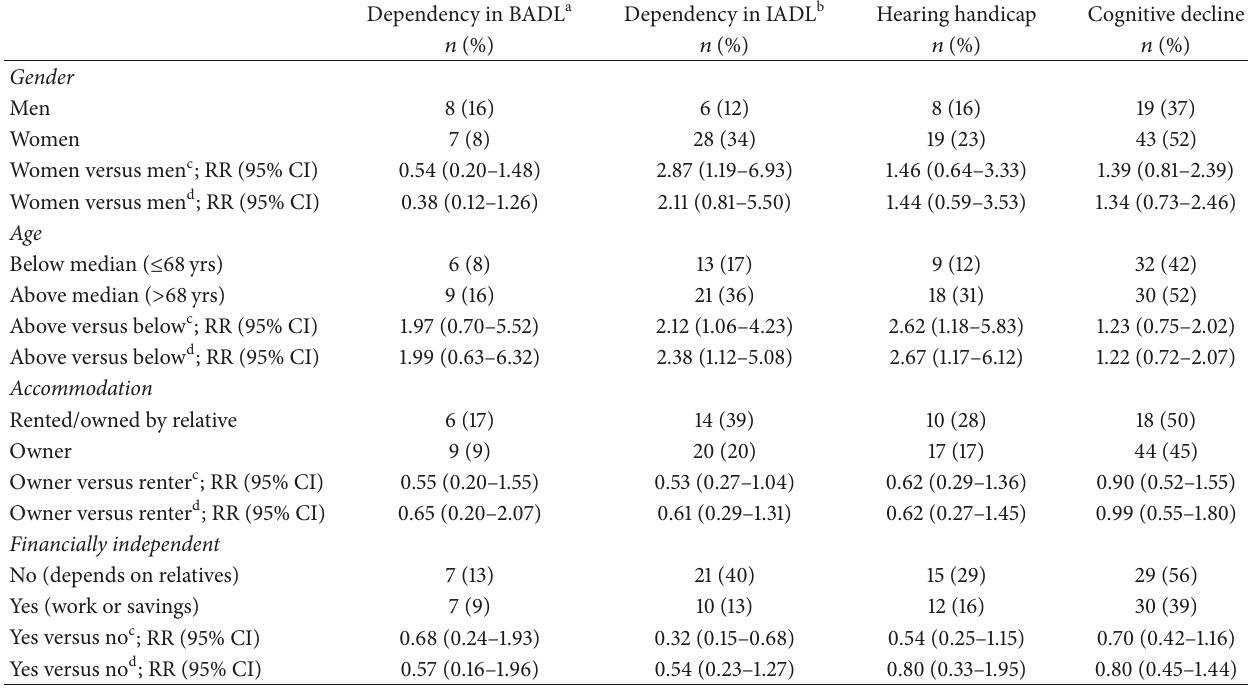
Table 3: Independency in daily living and ill-health across sociodemographic variables among the 134 study participants. Dependency in BADL